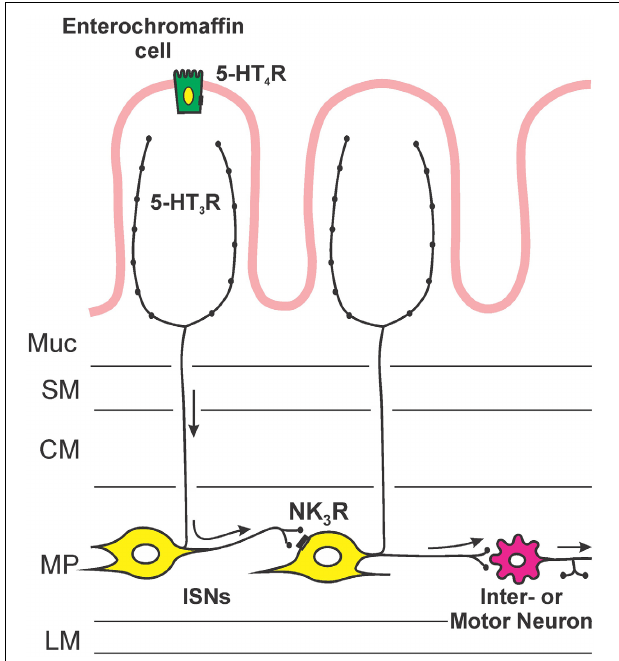
FIGURE 5 | An hypothesis about the sequence of mechanisms by which exogenous or endogenous 5-HT in the lumen enhances propulsion in the guinea-pig ileum. 5-HT acts on 5-HT 4 receptors on enterochromaffin cells to release more 5-HT, this higher concentration of 5-HT then excites mucosal terminals of myenteric AH neurons via 5-HT 3 receptors. The myenteric AH neurons then release tachykinins to enhance the excitability of distension-sensitive myenteric AH neurons via NK 3